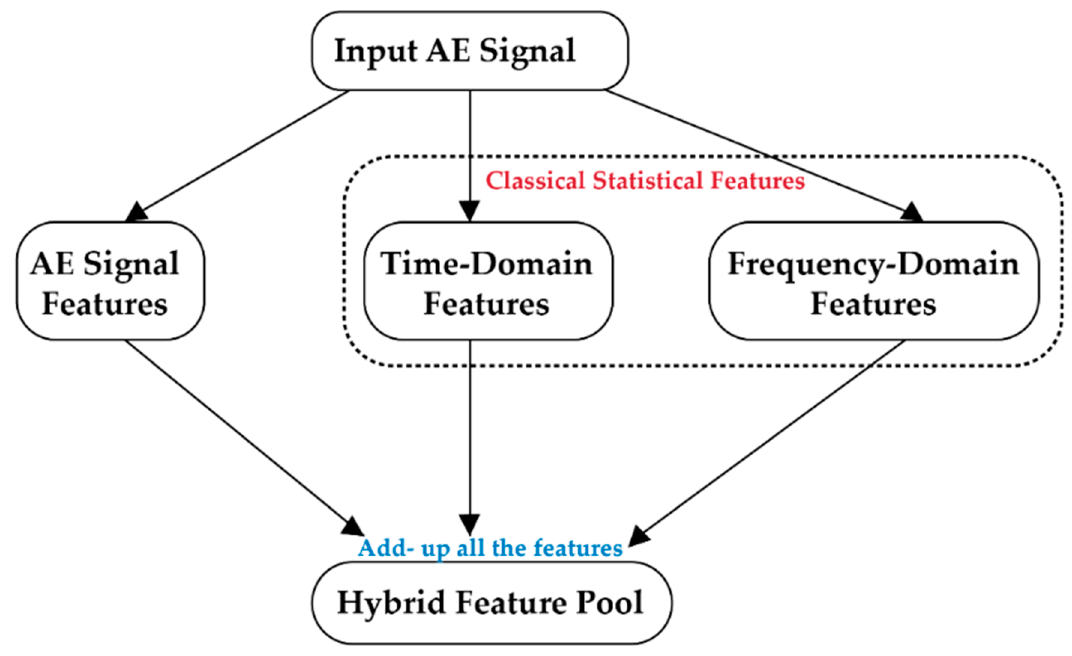
Figure 5. Hybrid feature pool creation process.